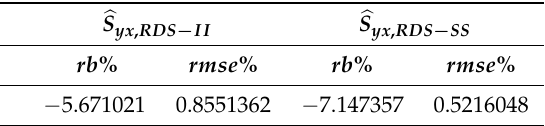
Table 3. Percent relative bias ( rb %) and the relative mean squared error ( rmse %) for estimating S yx with estimators (cid:98) S yx , RDS − II and (cid:98) S yx , RDS − SS for the ethnic example.